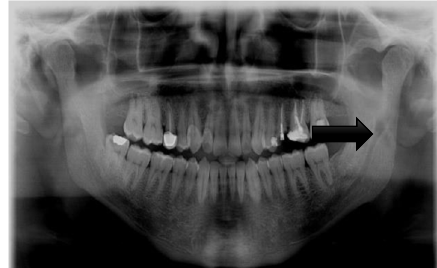
Figure 2. Image before cropping.